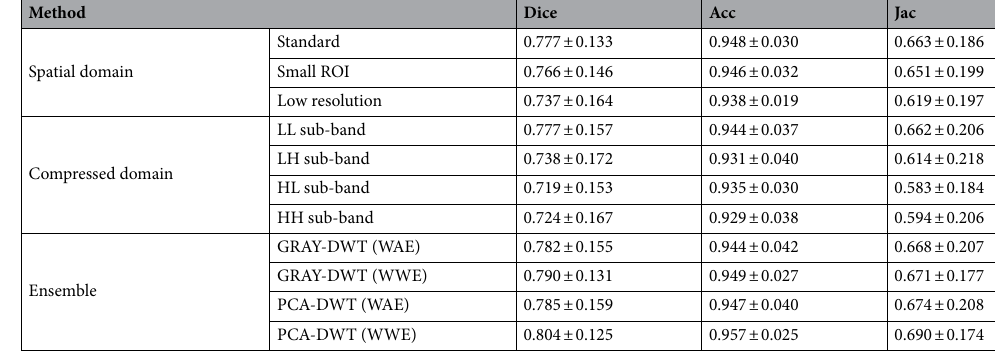
Table 1. Average Dice, Acc, and Jac values for the result of standard input in spatial domain (Tile size: 512 by 512, ×20 magnification, standard), the result of small ROI input in spatial domain (Tile size: 256 by 256, ×20 magnification, Small ROI), the result of low resolution input in spatial domain (Tile size: 512 by 512, ×10 magnification, low resolution), the result of weighted average ensemble (WAE) result for wavelet sub-band after grayscale conversion (GRAY-DWT (WAE)), the result of wavelet weighted ensemble (WWE) result for wavelet sub-band after grayscale conversion (GRAY-DWT (WWE)), the result of weighted average ensemble (WAE) result for wavelet sub-band after principle component analysis (PCA) (PCA-DWT (WAE)), and the result of wavelet weighted ensemble (WWE) result for wavelet sub-band after principal component analysis (PCA) (PCA-DWT